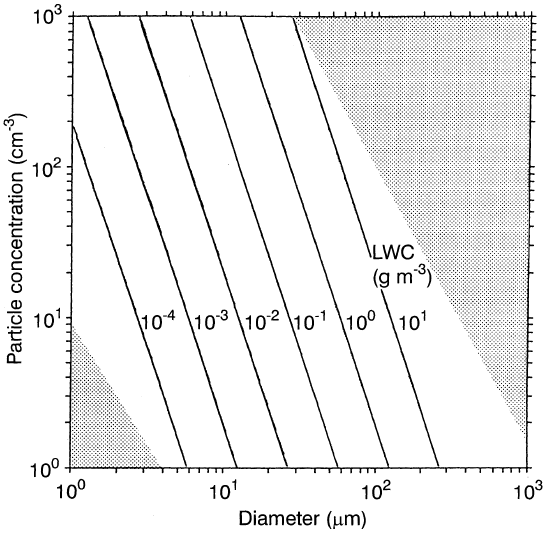
Fig. 3. Measurement range of the Polar Nephelometer versus the droplet size and concentration